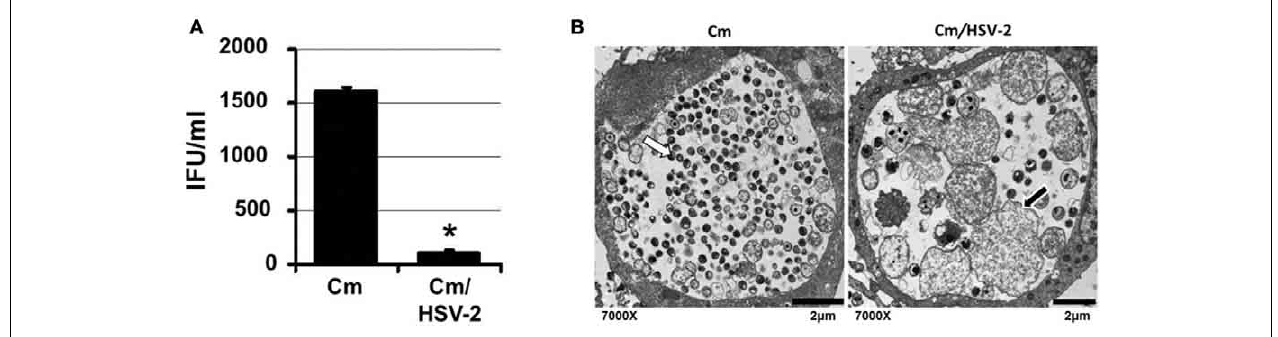
FIGURE 4 | HSV co-infection disrupts C. muridarum development. HeLa cells were either Cm- or Cm/HSV-2-infected. In co-infected cultures, cells were infected with Cm 6h before HSV-2 infection. Samples were collected